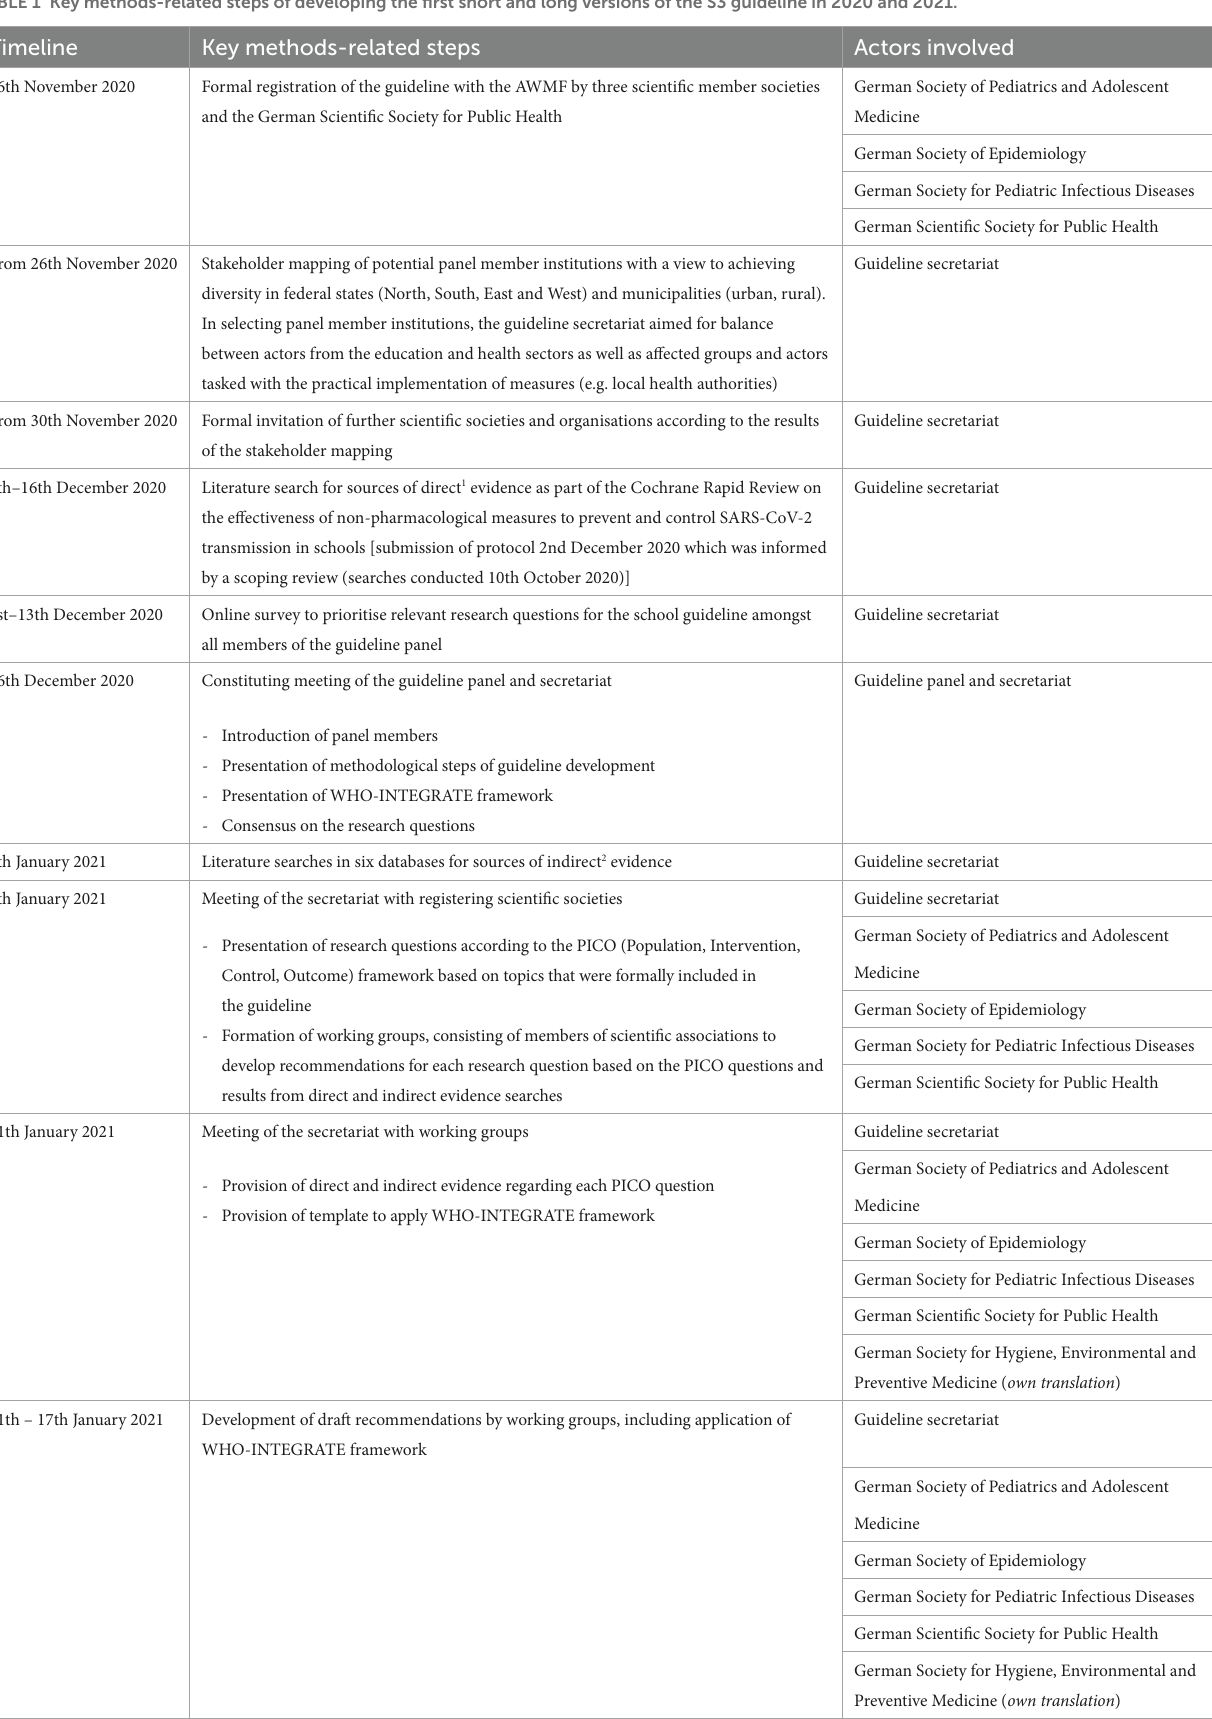
TABLE 1 Key methods-related steps of developing the first short and long versions of the S3 guideline in 2020 and 2021.